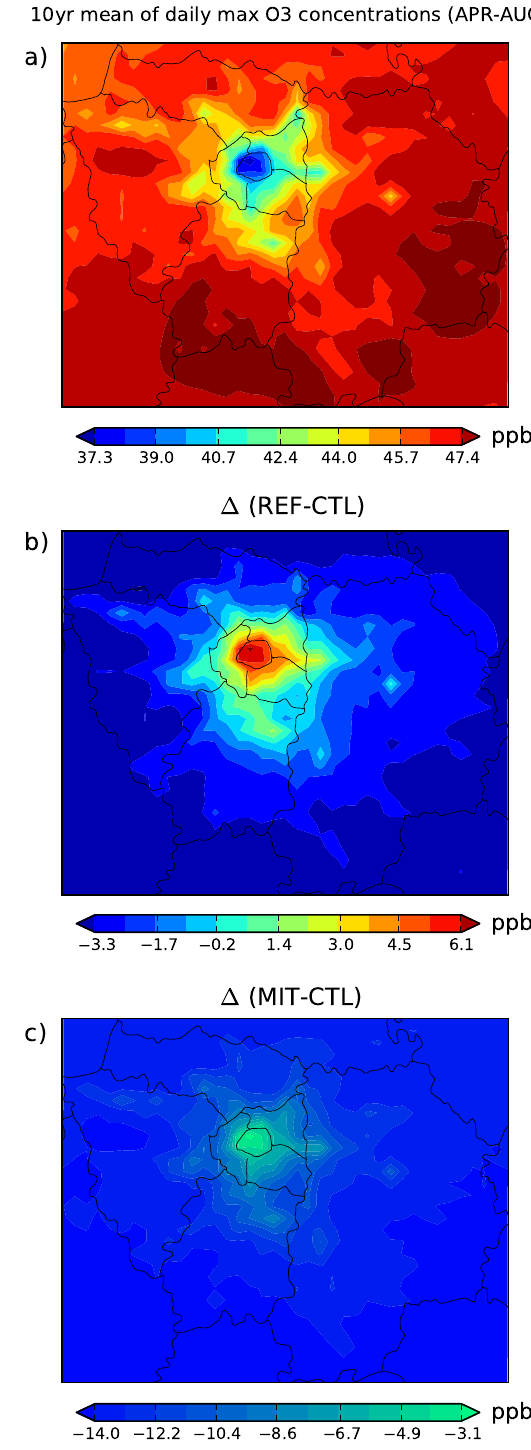
Figure 4. Present-day ozone daily maximum (ppb) of 8hr running means averaged over the April–August period (a) and differences between the CTL run and the REF (b) and MIT projections (c)